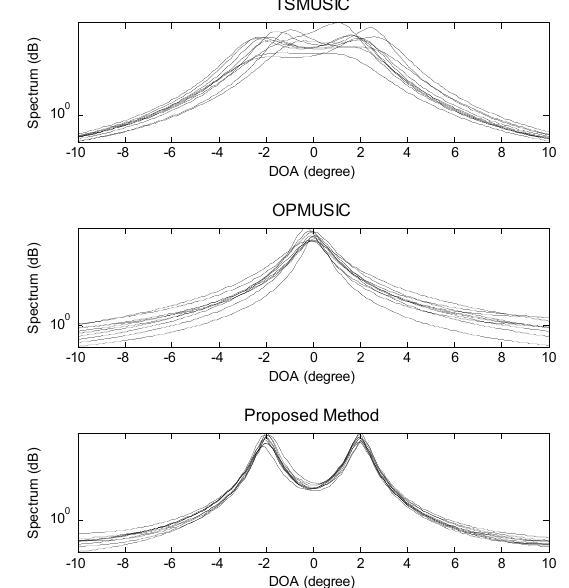
Figure 3. Mixed sources DOA spectra obtained with Two-Stage MUSIC (TSMUSIC), Oblique-Projection MUSIC (OPMUSIC) and the proposed method. 10 independent trials are realized for each method.